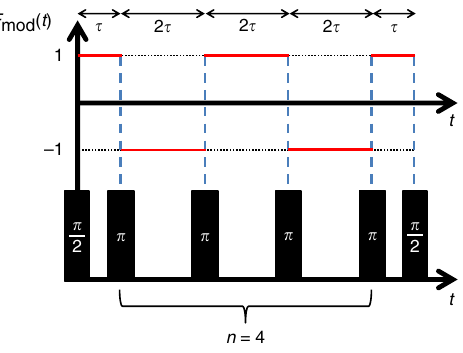
Figure 2 | Schematic modulation function timeline. Modulation function F mod ( t , t , n ¼ 4) (upper timeline) and the corresponding experimental pulse sequence (lower